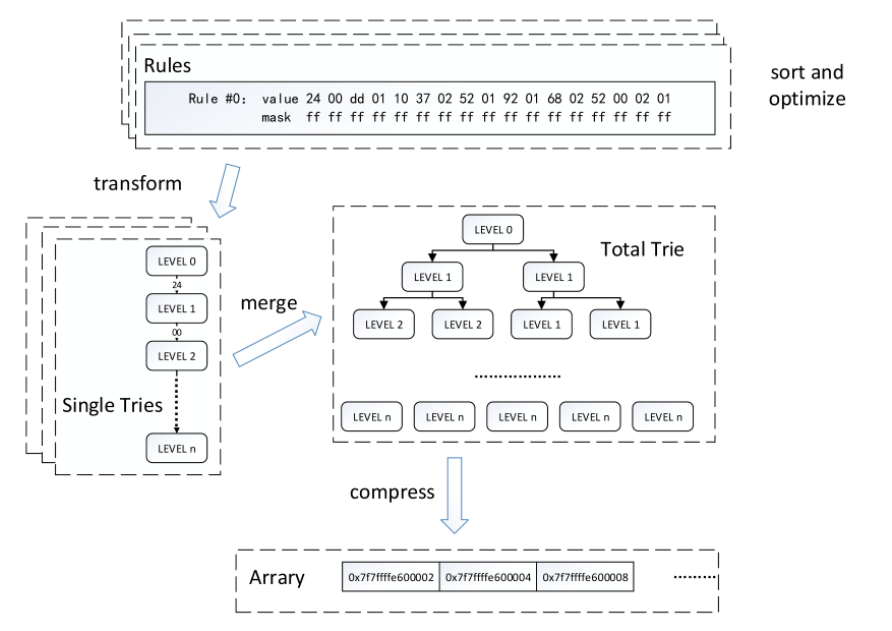
Figure 2. The buildup process of DPDK